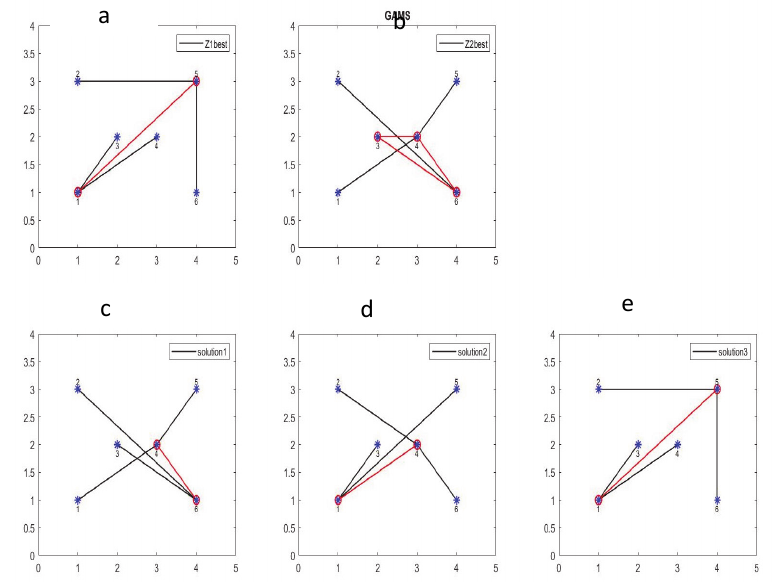
Fig. 5 : How to assign non-hub nodes to hub nodes in problem-solving using a comprehensive benchmarking method